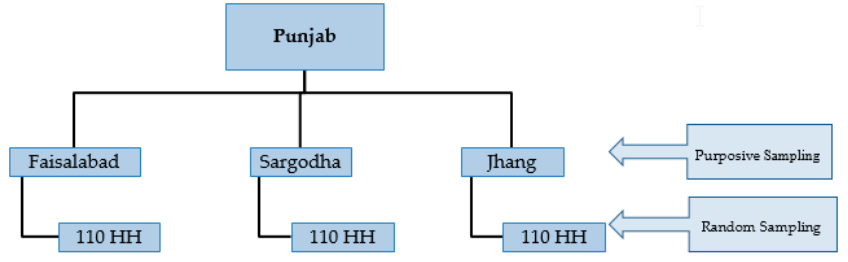
Figure 2. Sampling frame. Source: Own illustration. HH =